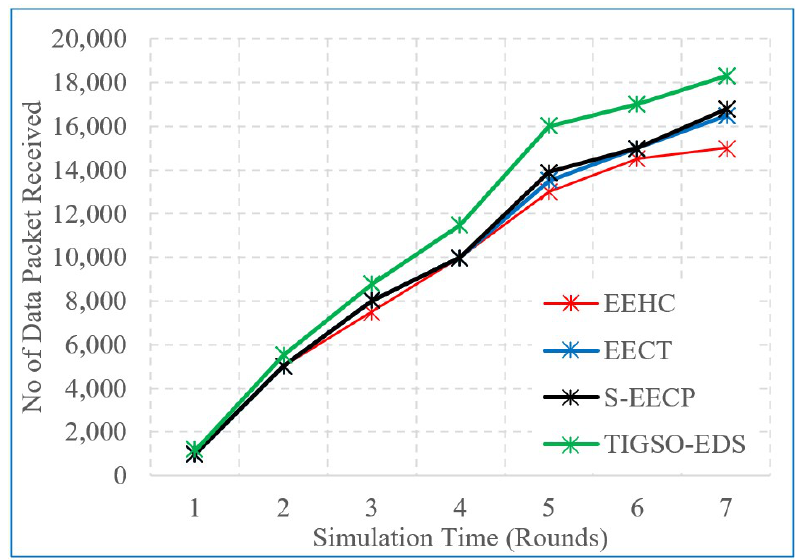
Figure 6. Comparison of data packets received at the base station (BS) located at 50 × 50).